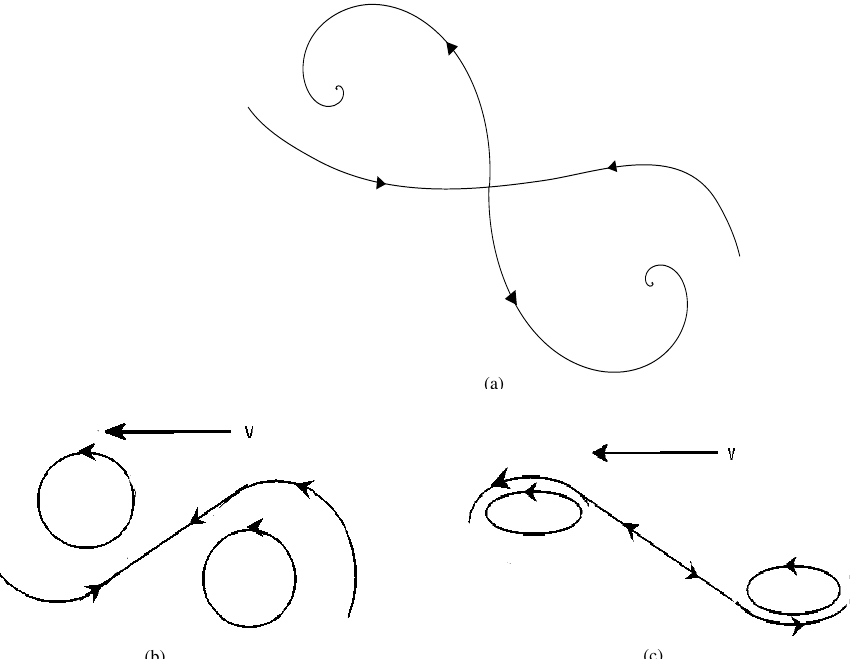
Fig. 10. A pair of convergent vortices on opposing sides of a saddle are kept from finite-time interaction (a). Stable (b) and unstable (c) vortex interactions occur along a single manifold segment when the other manifold branch is not obtained under short integration times.